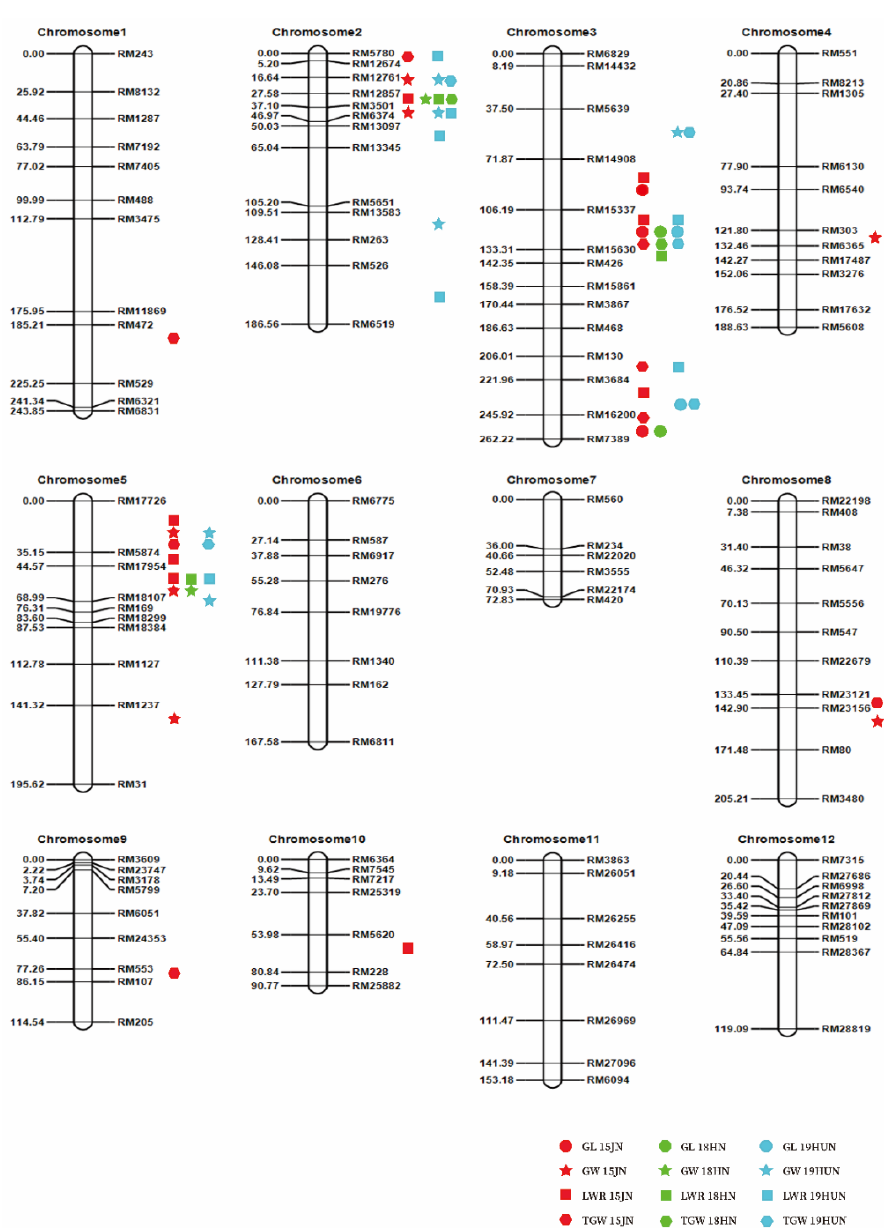
Figure 4. Distribution of identified quantitative trait loci (QTL) for grain size and grain weight on genetic linkage maps in F 2 populations. The marks denote peak positions of QTL; 15JN, 18HN, and 19HUN represent Jining in 2015, Hainan in 2018 and Hunan in 2019, respectively. Numbers on the left side are the genetic distances between two flanking markers with the unit centiMorgan (cM).